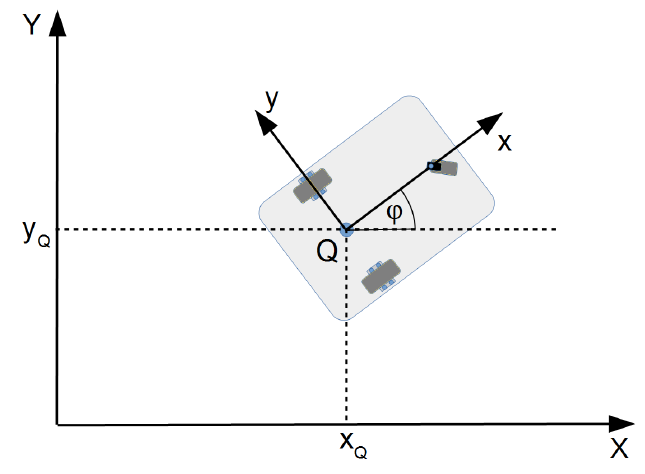
Figure 6. Global and local coordinates of the mobile